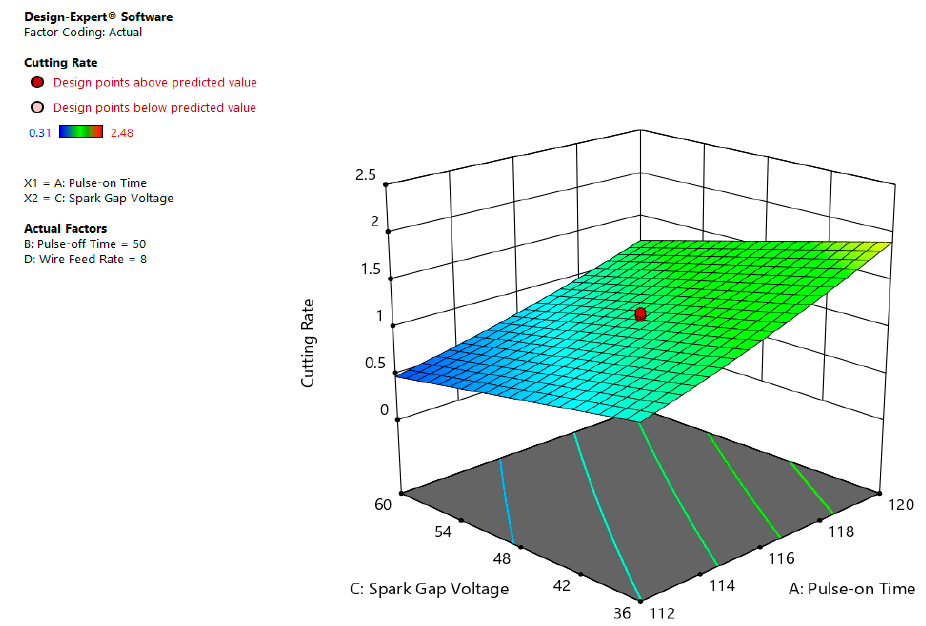
Figure 7. Interactive impact of Ton and SV on CR.